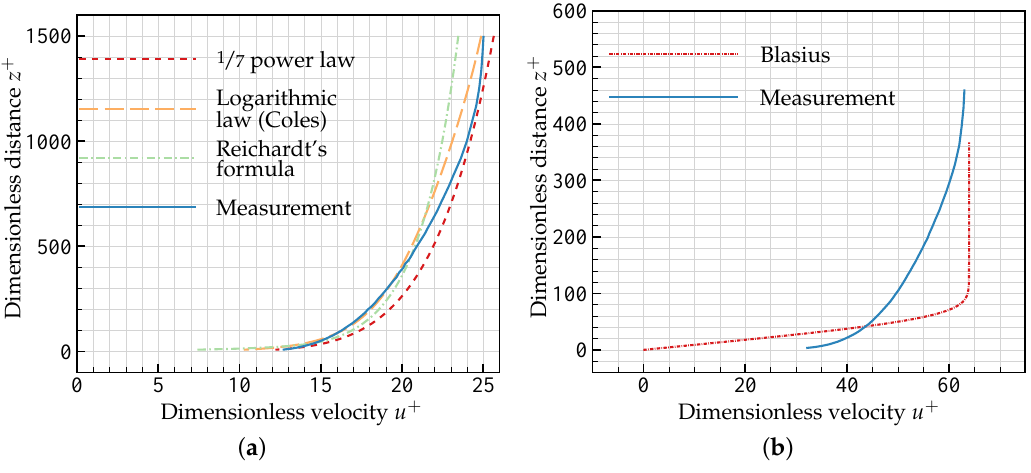
Figure 8. Dimensionless velocity profiles at 45ms − 1 with a distance of x = 350mm from the nozzle outlet. ( a ) Turbulent presumed boundary layer in case of shear stress 1; ( b ) Laminar presumed boundary